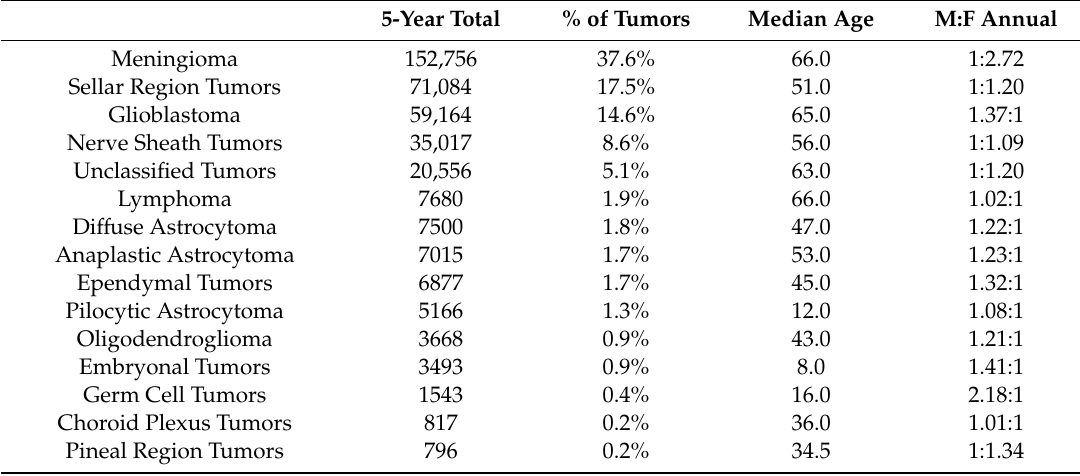
Table 1. Demographics of common primary brain tumors in the United States from